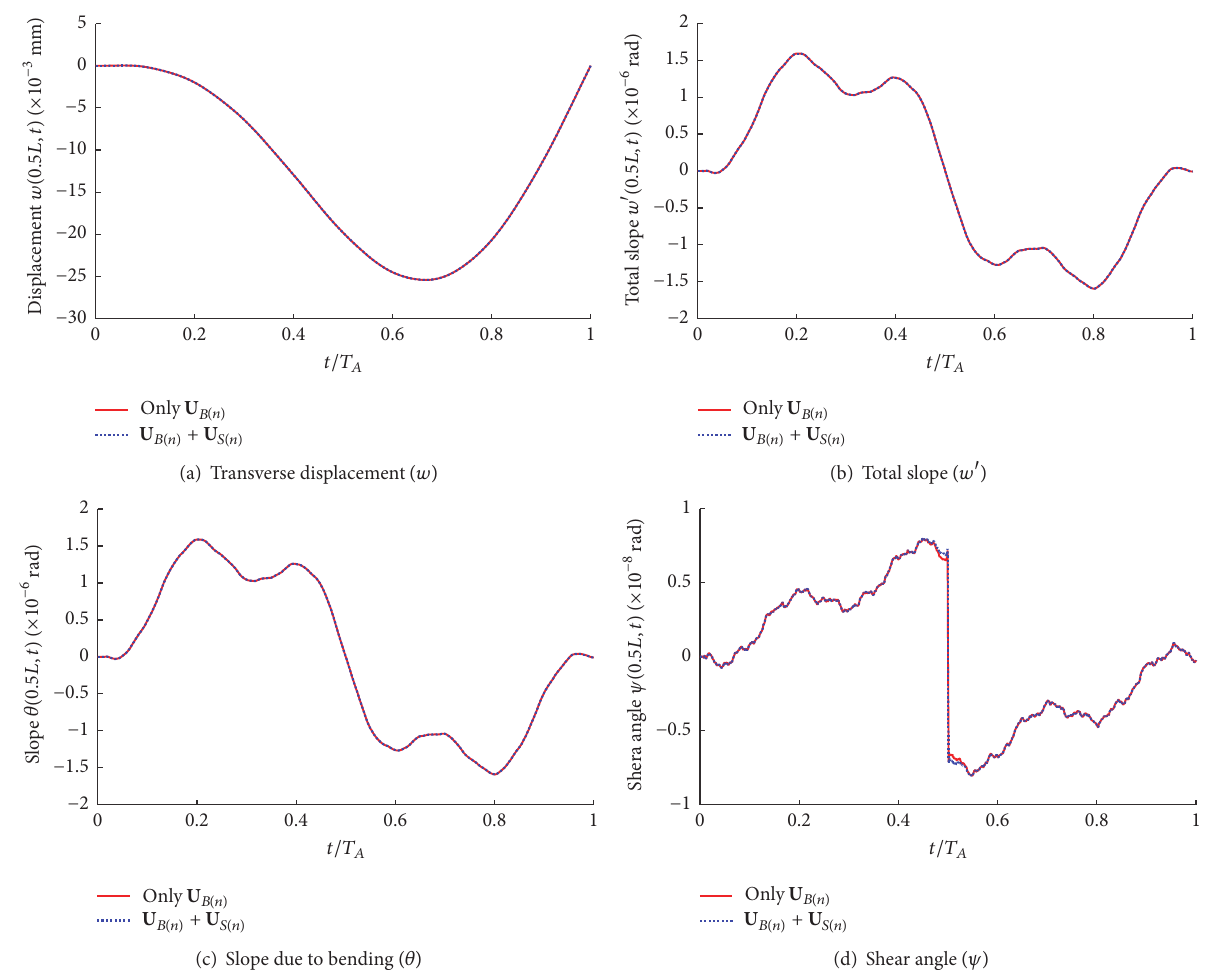
Figure 9: Dynamic responses at 𝑥/𝐿 = 0.5 of a simply supported Timoshenko beam subjected to a point transverse force moving at a constant speed of V 𝑓 = 0.5 V cr : (a) transverse displacement (𝑤) ; (b) total slope (𝑤 󸀠 ) ; (c) slope due to bending (𝜃) ; (d) shear angle (𝜓)